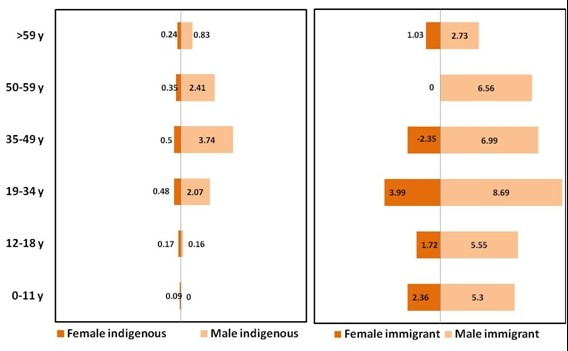
Incidence rate in Catalonia 2005-2007 according to: age group (y axis), gender (dark orange) for females and (pale orange) for males and nationality (left panel) for indigenous subjects and (right panel) immigrants.